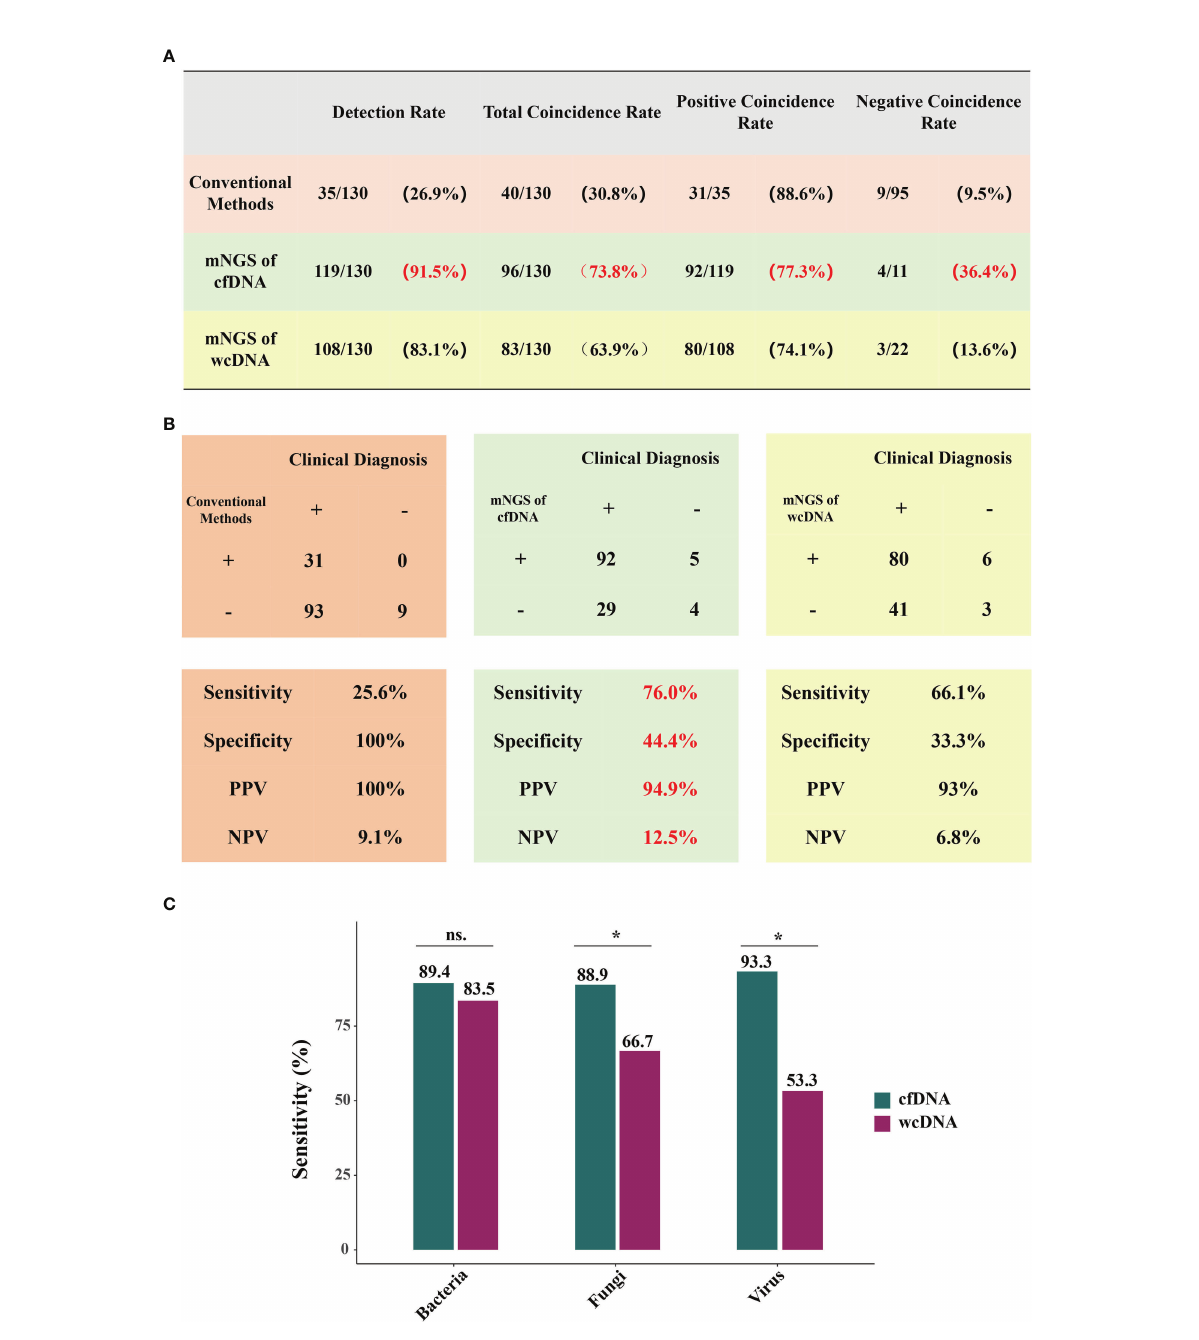
FIGURE 2 Performance of mNGS using cfDNA/wcDNA and conventional methods. (A, B) show the coincidence rates, sensitivity, speci fi city, PPV, and NPV of conventional methods, mNGS of cfDNA, and mNGS of wcDNA. PPV and NPV represent positive predictive value and negative predictive value, respectively. (C) , Comparison of mNGS using cfDNA and wcDNA at bacterial, fungal, and viral levels. *P < 0.05; ns: no signi fi